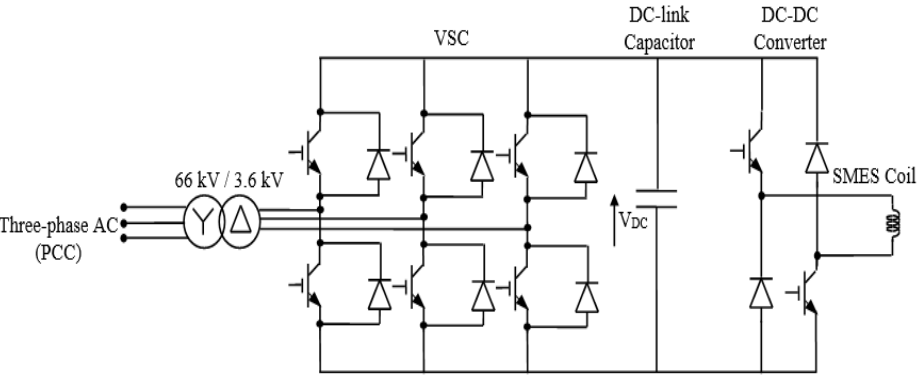
Figure 2. SMES Model.